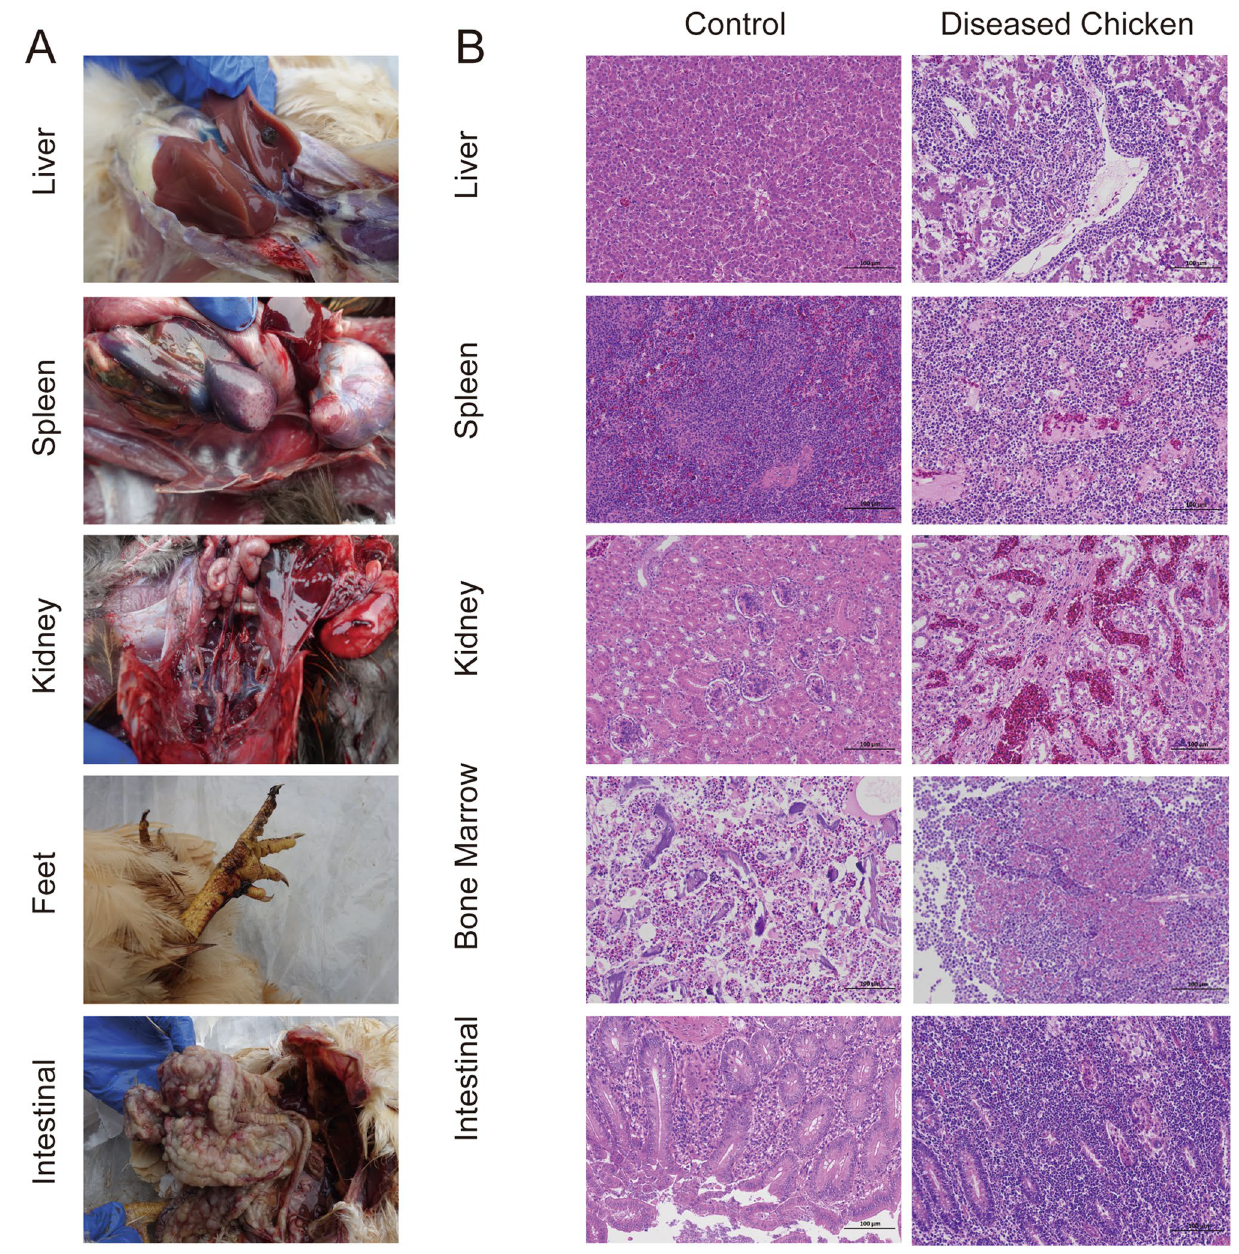
Figure 1. Anatomical and histological examination of sampled chicken. ( A ) Sampling chicken’s liver, spleen, kidney, feet and intestinal; ( B ) pathological sections of diseased chicken and control (H&E stain, 400